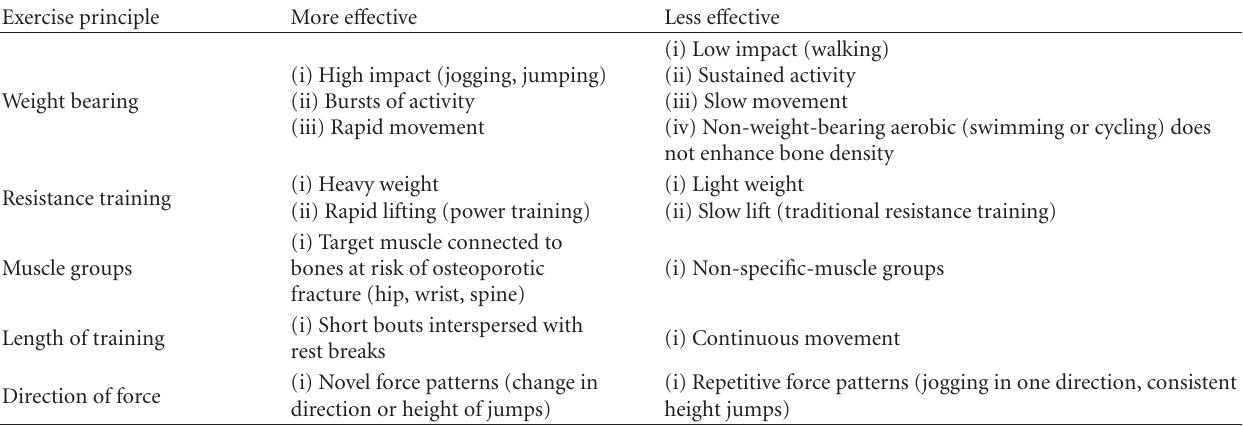
Table 3: Principles of exercise to maximise bone adaptation.